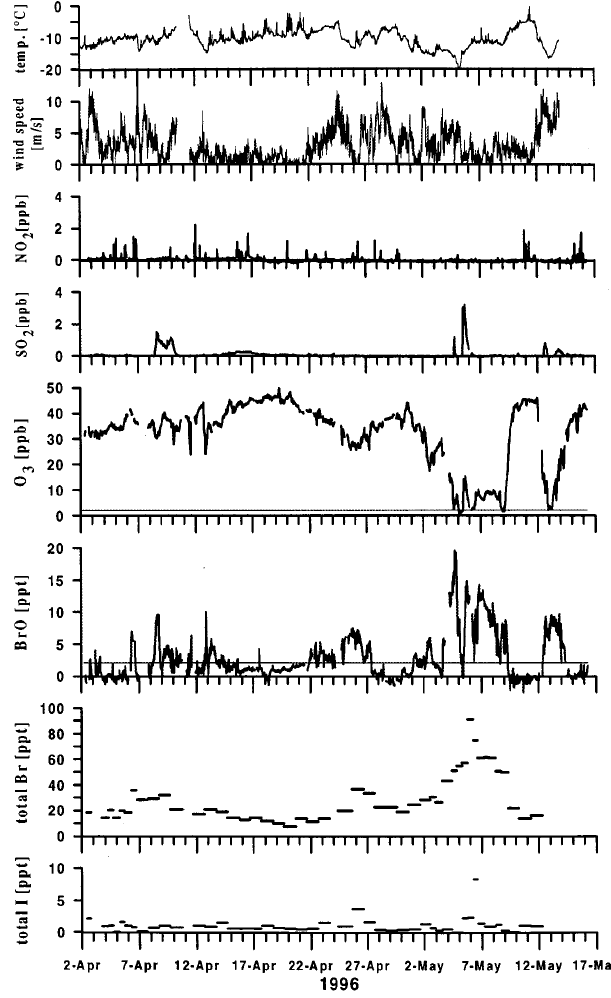
Fig. 6. ARCTOC 1996: all data of NO 2 , SO 2 , O 3 and BrO measured by DOAS during the campaign together with temperature and wind speed at Zeppelin station (ARCTOC, 1997). Total bromine and iodine collected on active charcoal and measured by neutron